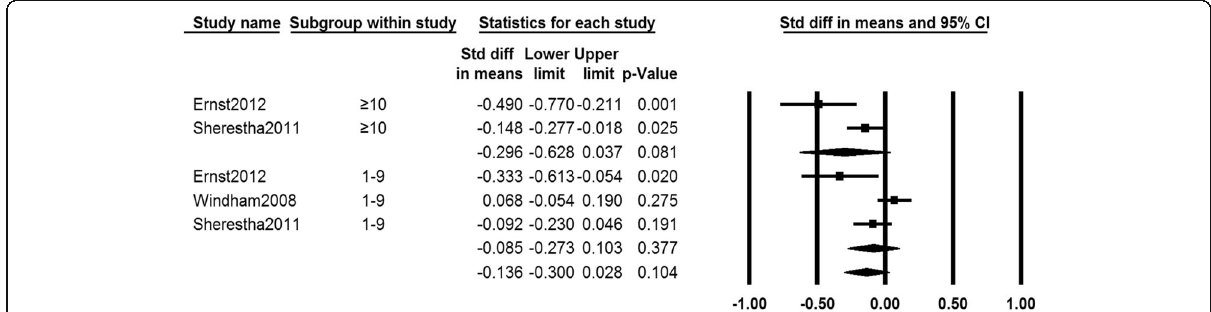
Fig. 3 Forest plot for the age at menarche between different PTS exposure levels group and control